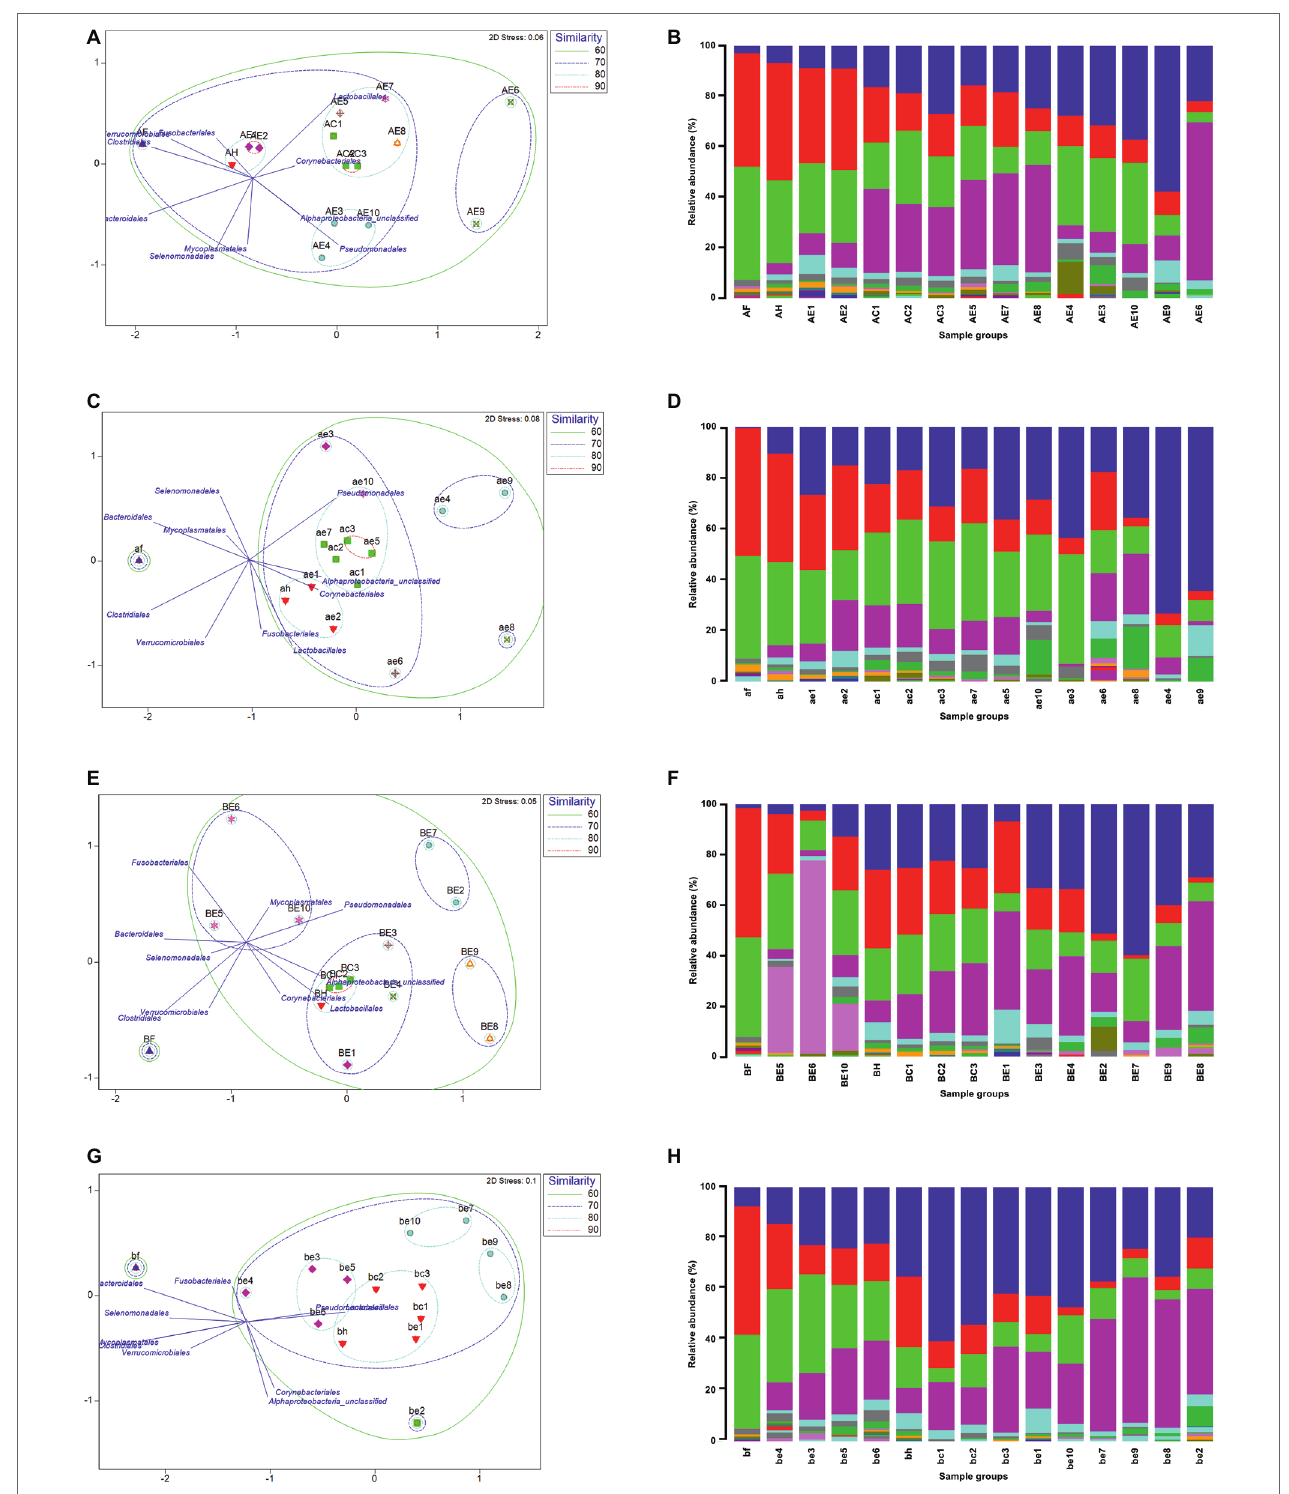
FIGURE 4 | Non-metric multidimensional scaling (nMDS) ordination showing the similarity in bacterial community composition using S17 Bray-Curtis and overlay vectors of the top 10 OTUs (left) and relative abundance of 27 Order OTUs in all sample groups (right). First abattoir A visit is shown in (A) and (B) and second visit in (C) and (D) . First visit to abattoir B in (E) and (F) , and second visit in (G) and (H) . Physical distance between each group in the ordination indicates the similarity of the two or multiple groups. Displacement of the OTUs in the same ordination represents the distribution of each OTU. Fecal (F or f), hide (H or h), carcase (C or c), and environmental (E or e) groups are labeled in upper and lower cases for the first and second visits for each abattoir,